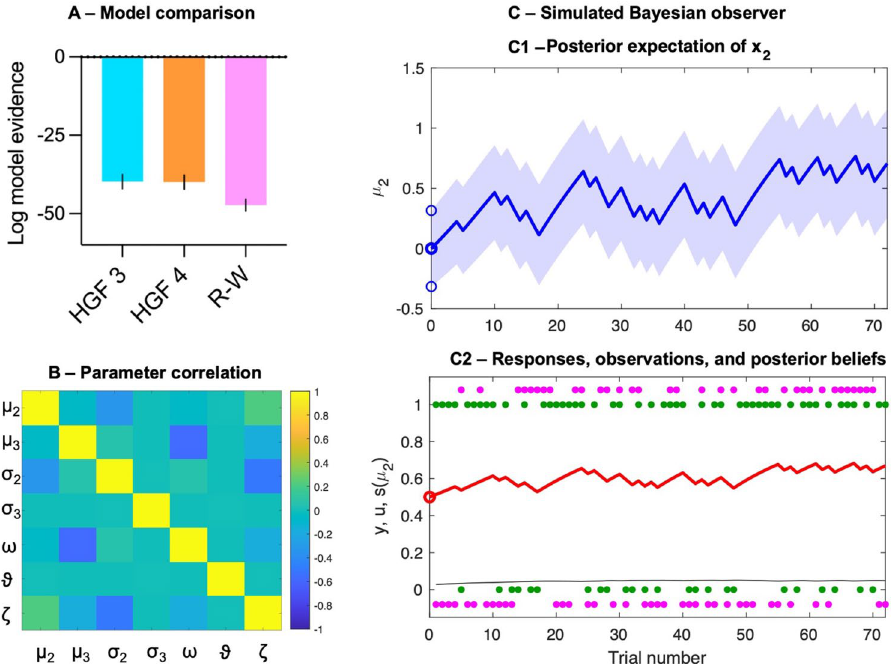
Figure 5. Model development. ( A ) Comparison of model fits showing LME for each model type (and SEM error bars), where higher values indicate better fit. ( B ) Heat plot of averaged correlation matrices for model parameters; parameters should not be highly correlated if they are independently identifiable. No correlations were sufficiently strong as to suggest that one parameter could be substituted for another (σ i = precision of belief at level i; μ i = mean of belief at level i; ω = variance of random walk at x 2 ; ϑ = variance of random walk at x 3 ; ζ = decision noise). ( C ) Illustration of the belief trajectory for a simulated Bayesian agent in this task. C1 shows the evolving mean and variance of the posterior beliefs for μ 2 . C2 shows inputs/observations (green dots), responses (cyan dots), learning rate (black line), and posterior belief (red